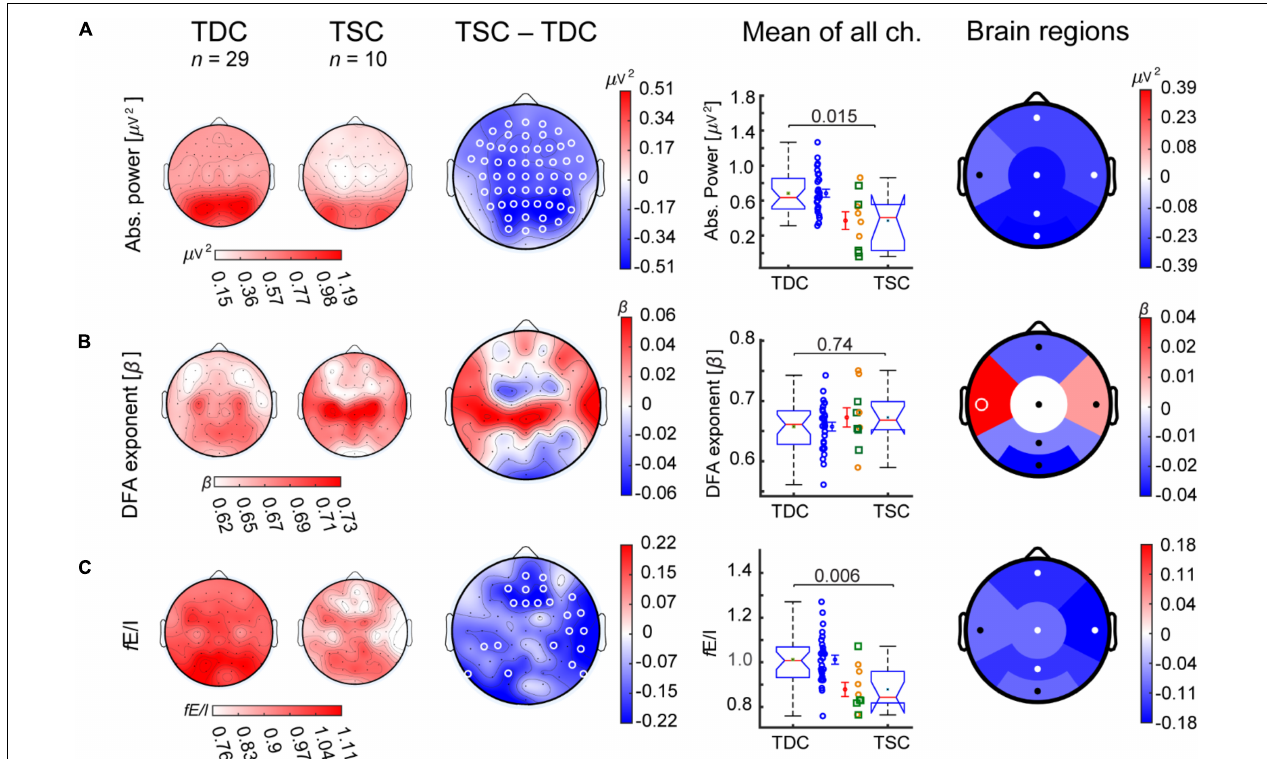
FIGURE 2 | Participants with TSC show lower alpha-band absolute power and f E/I than TDC. Grand-average topographies are shown for TDC ( first column ), TSC (D0; second column ), and for TSC-minus-TDC ( third column ) for the alpha-band biomarkers (A) absolute power, (B) DFA, and (C) f E/I. (A) The TSC group (D0, baseline) showed lower absolute power compared to TDC in most electrode locations and regions. (B) The DFA exponent was not different between groups. (C) f E/I ratios were also lower in TSC compared to TDC, particularly in frontal and temporal right regions. Comparisons in boxplots ( fourth column ) were based on the average value of the EEG biomarkers across all 64 channels (Wilcoxon rank-sum test). Individual-subject values, mean, and SEM are shown for TDC ( blue circles ) and TSC [concomitant treatment with antiepileptic drug ( yellow circles ) or not ( green squares )]. Comparisons between groups are also shown for regional averages of frontal, temporal left, temporal right, central, parietal, and occipital electrodes ( fifth column ). White circles represent significant regions ( p -value < 0.05, Wilcoxon rank-sum test, FDR